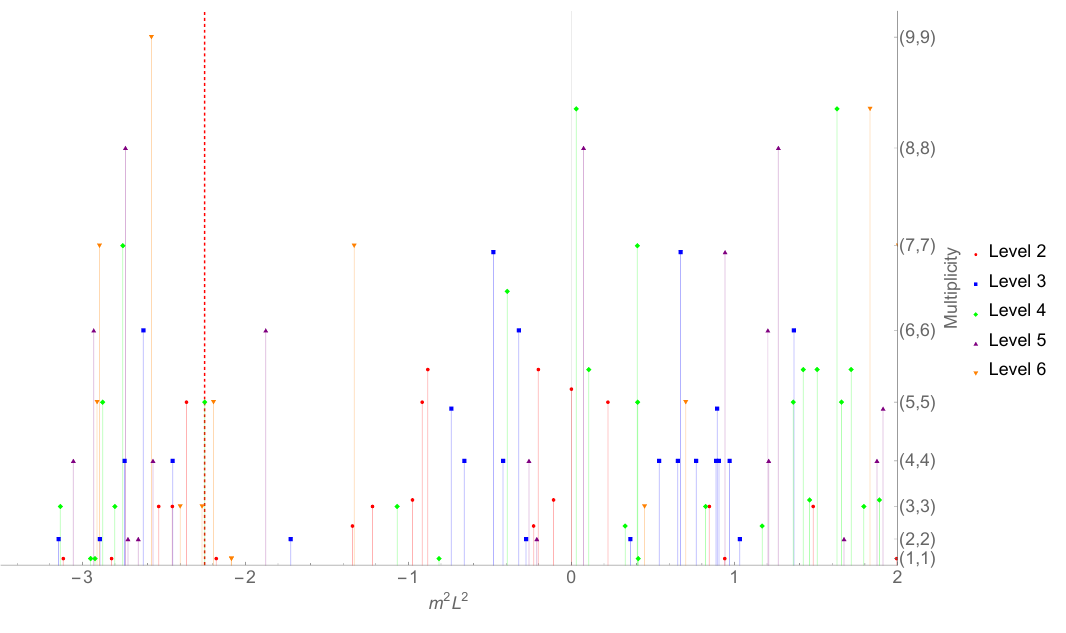
Figure 2 . Spectrum of scalar Kaluza-Klein modes with masses in the range (cid:0) 3 : 5 (cid:20) m 2 L 2 (cid:20) 2 with the BF bound m 2 L 2 = (cid:0) 2 : 25 represented as a dashed red line. Here, m is the mass of the mode, L is the AdS length and the vertical axis shows the multiplicity which is determined by the SO(3) (cid:2) SO(3) representation of the modes.